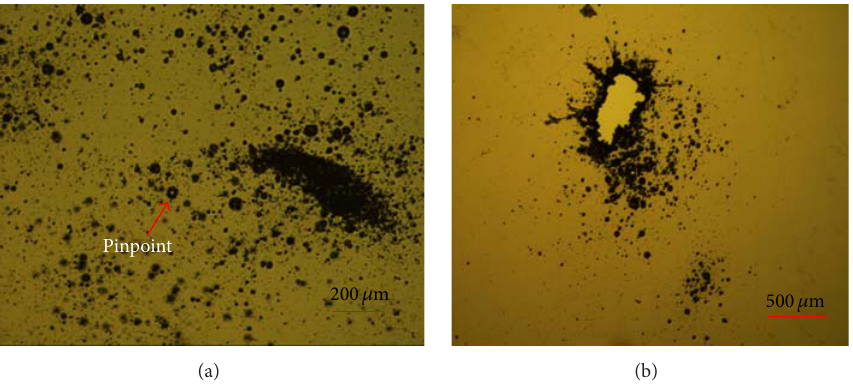
Figure 6: Microscopic-morphologies of laser induced damage: (a) the laser energy density within 3.35 J / cm 2 ∼10.35 J / cm 2 (second process) and (b) the laser energy density higher than 10.35 J/cm 2 (third process).